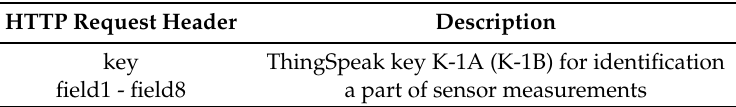
Table 2. Data format description for M-2A and M-2B.